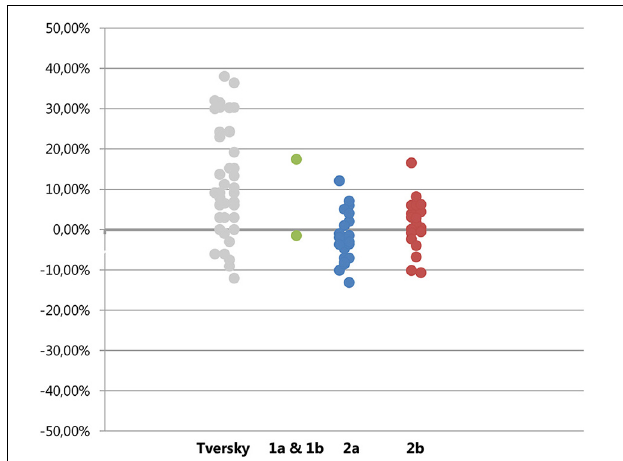
Frontiers in Psychology |